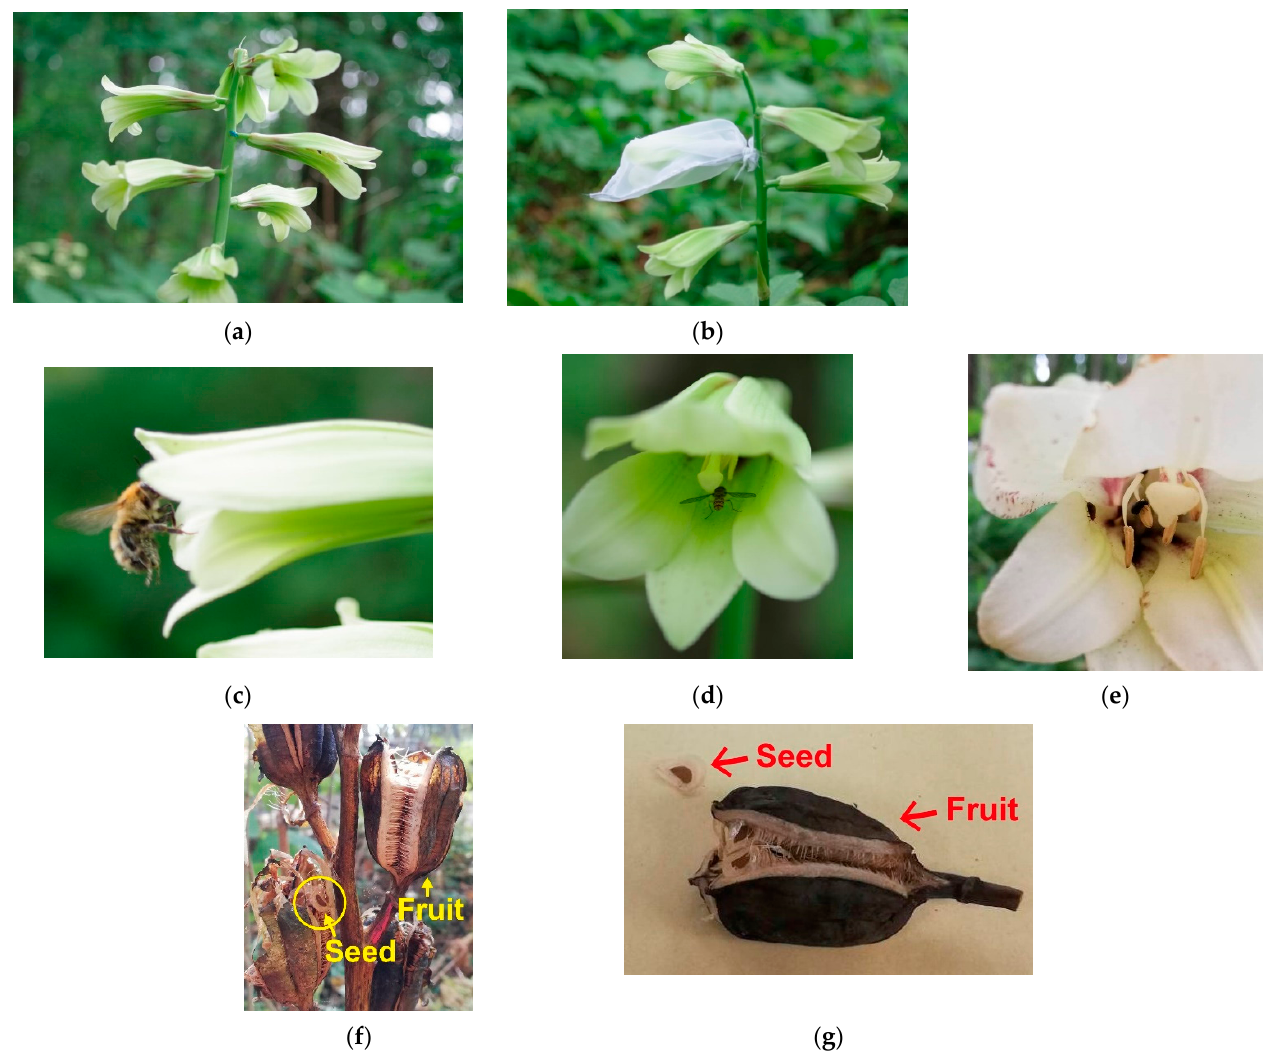
Figure 1. Flowers of Cardiocrinum cordatum (Thunb.) Makino. ( a ) An inflorescence; ( b ) pollinator exclusion experiment using polyester bags; ( c ) a bumblebee ( Bombus diversus tersatus ); ( d ) a marmalade hoverfly ( Episyrphus balteatus ); ( e ) leaf beetles ( Chrysomelidae sp.); ( f ) and ( g ) fruits and seeds. Photographs were taken at Hokkaido Obihiro Agricultural High School ( a – e ) in July and ( f , g ) in October, in 2020, by ( a – d ) Kohei Koyama and ( e – g ) Riko Komamura. The original high-resolution images are available as Supplementary Materials.